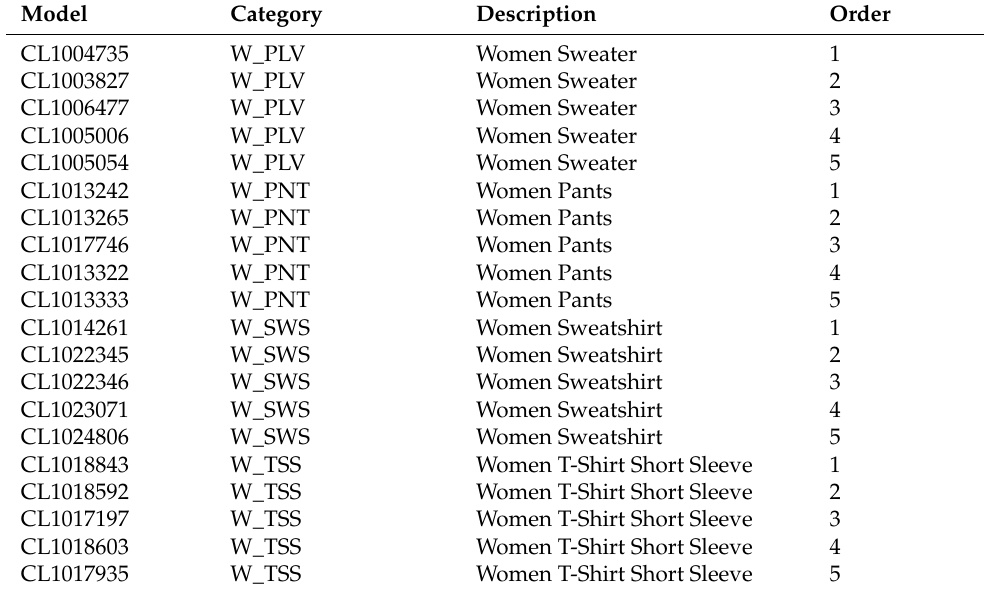
Table 6. A recommendation list was created for the selected